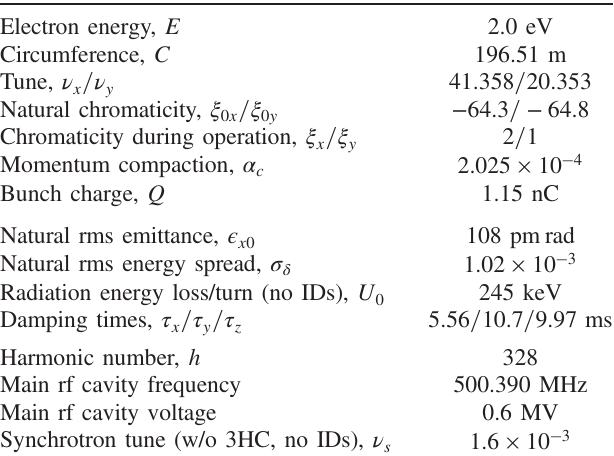
TABLE I. ALS-U storage-ring main